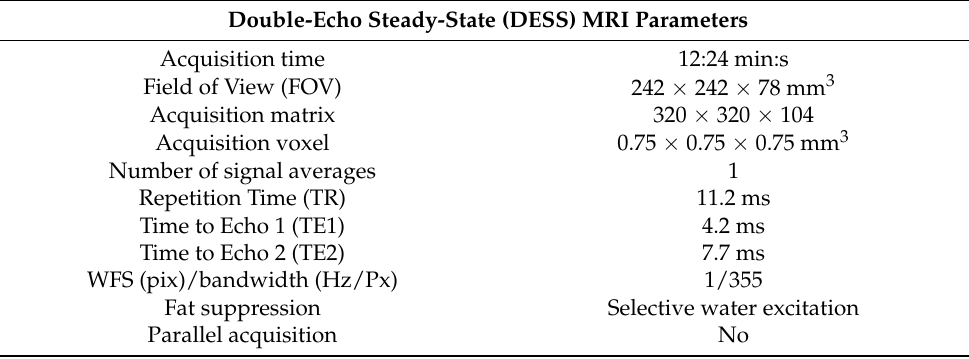
Table 1. Main technical parameters of the 3D Double-Echo Steady-State (DESS) MRI protocol.